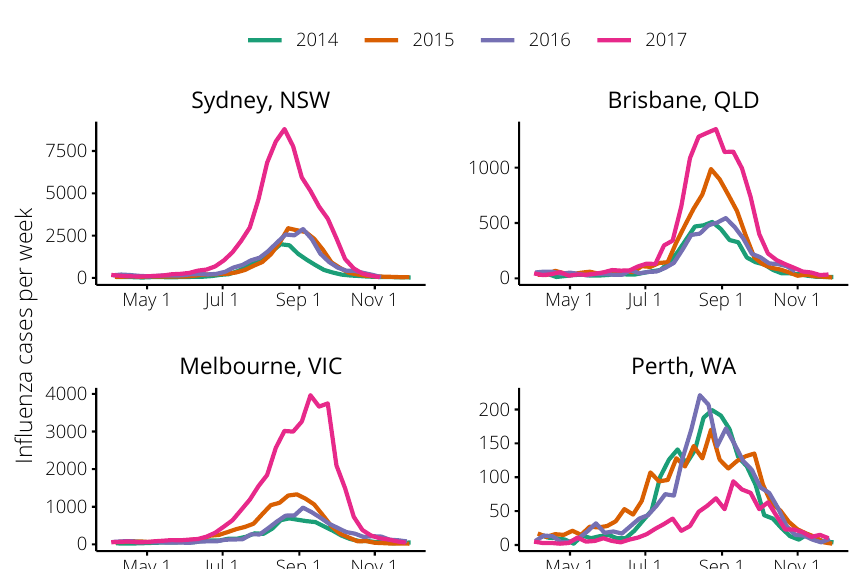
Figure 2. Weekly laboratory-confirmed influenza cases reported in each of the 2014–2017 seasons for the cities of: Sydney, New South Wales ( top-left ); Brisbane, Queensland ( top-right ); Melbourne, Victoria ( bottom-left ); and Perth, Western Australia ( bottom-right ). In all states except Western Australia (where the data comprise a greater proportion of hospitalised cases, see main text), the 2017 season was much larger than the 2014–2016 seasons. Queensland also experienced quite a large season in